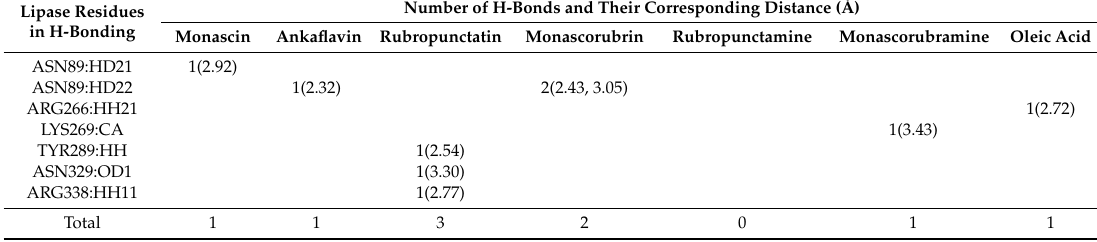
Table 7. Hydrogen bonds observed in the best scored docking model of the six main MPs and Oleic acid within lipase (PDB: 1EHT). Number of H-Bonds and Their Corresponding Distance (Å) Lipase Residues in H-Bonding Monascin Ankaflavin Rubropunctatin Monascorubrin Rubropunctamine Monascorubramine